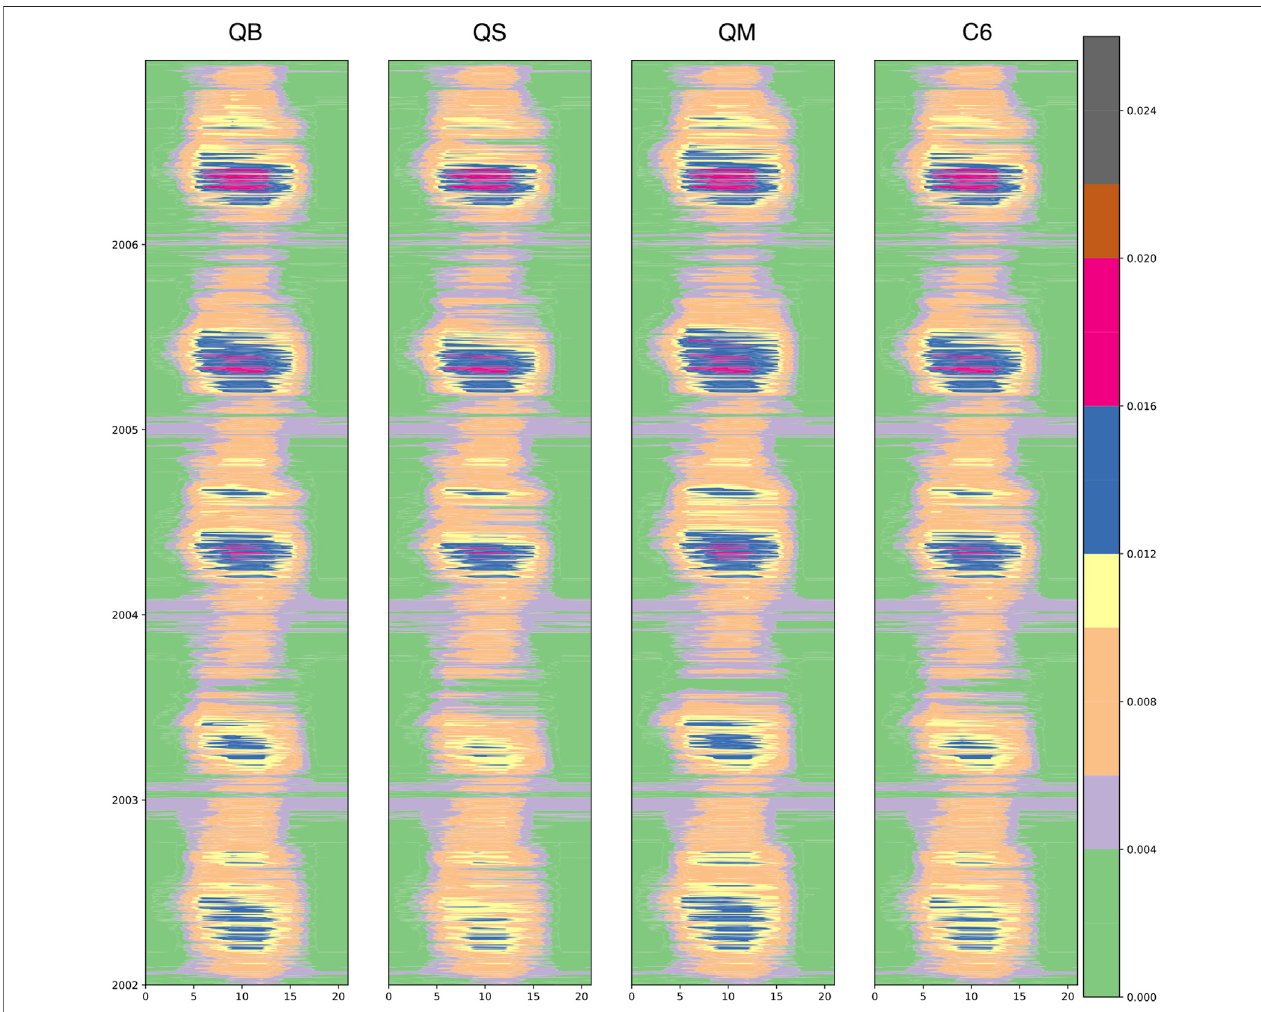
FIGURE13| Thediurnalandseasonalevolutionofstomatalconductance(g s ,m s − 1 )as fi lledcontours fortheJULESPlantFunctionalType1(BroadleafTrees)ata grid point inFrance. Thediurnalcycle (GMThour) isshown onthe x axis,while theseasonalcycle(indicated byyearsfrom 2002to2006,top) isshown onthe y axis.The four experiments are QB, QS, QM, and C6 in each